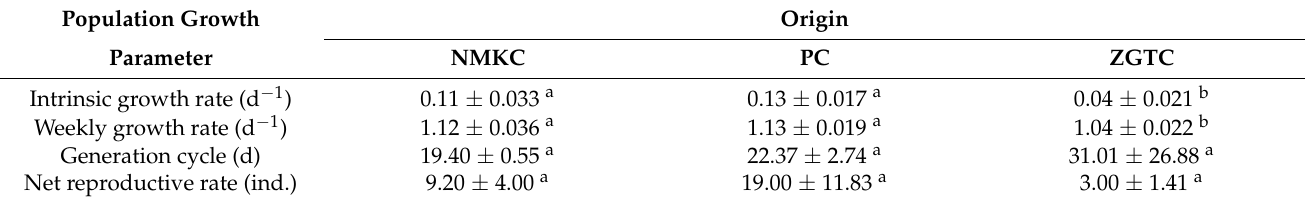
Table 1. Comparison of population growth parameters of Daphniopsis tibetana from different origins.